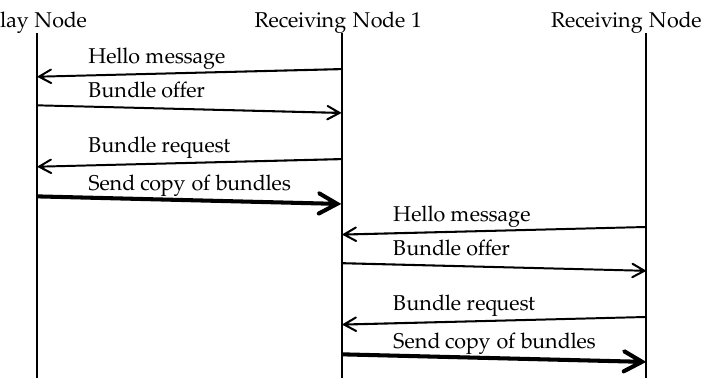
Figure 15. Procedure for relaying a bundle between relay nodes. Note: the bold arrow shows that a bundle copy is sent.